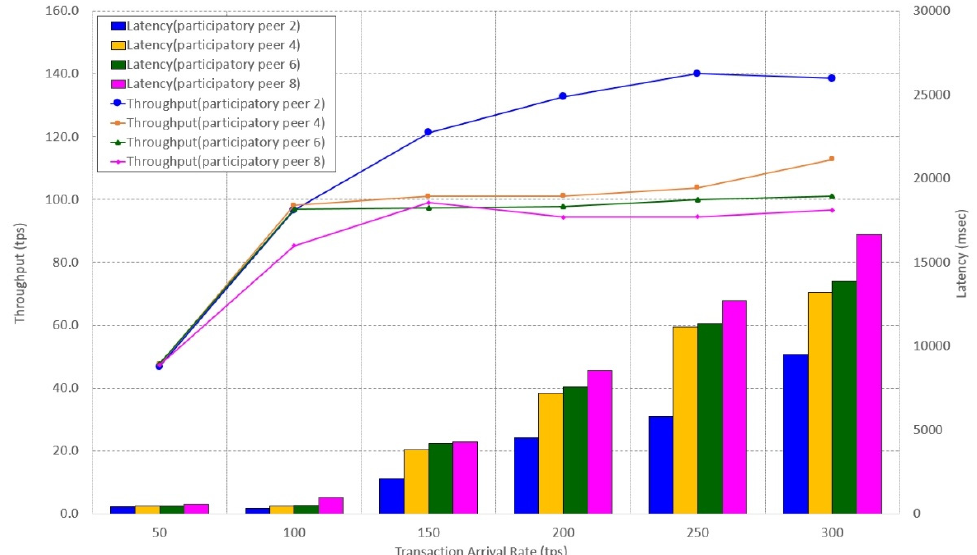
Figure 14. Performance of write in BC of proposed framework under different workloads and different number of peers.